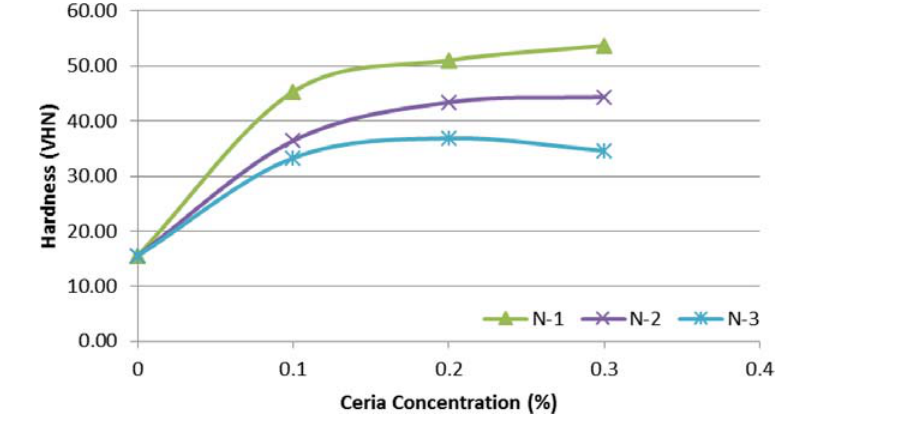
FIG. 7. ANODE HARDNESS AS A FUNCTION OF CERIA